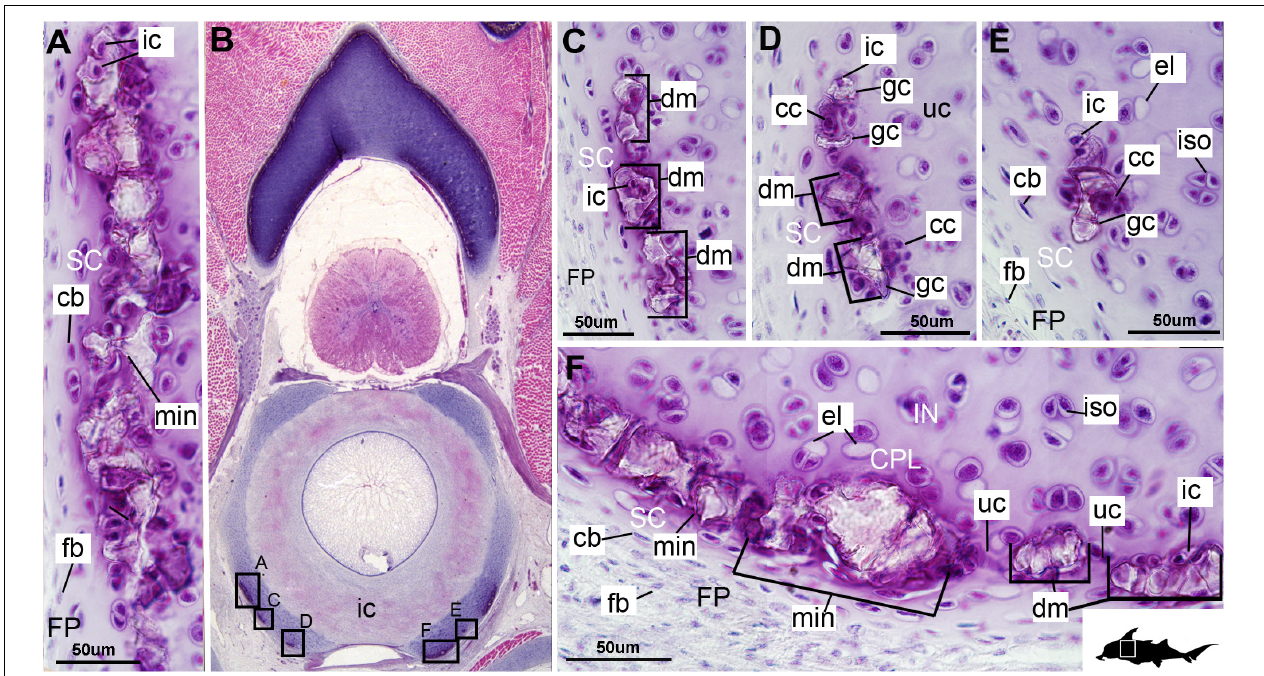
FIGURE 4 | Histological section through the anterior synarcual (anterior fused vertebrae) of a stage 36 embryo of Callorhinchus milii (Holocephali; Callorhinchidae). (A,C–F) Closeups showing perichondrium, cartilage, and mineralization in basiventrals; (B) overview of section through the neural arch with locations of closeup views indicated by black squares. Abbreviations: As in previous figures. Black silhouette of C. millii indicates approximate region shown in the